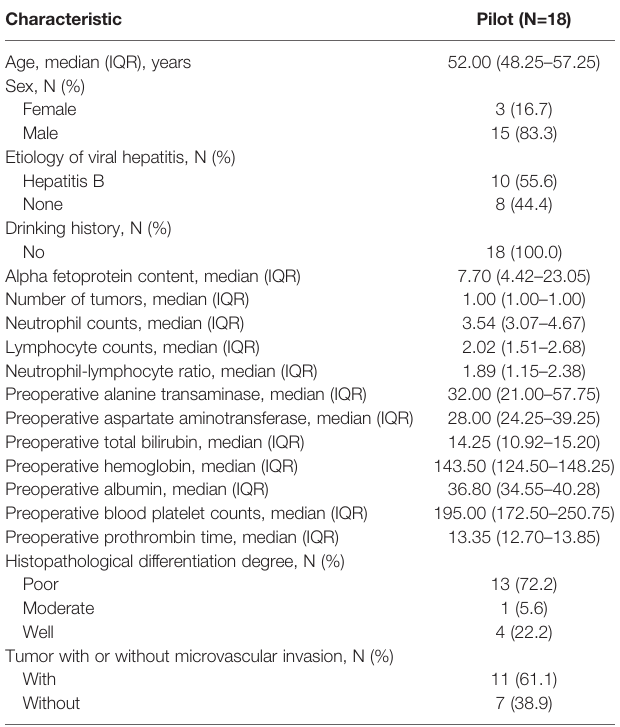
TABLE 2 | Demographic and clinicopathologic characteristics of the pilot